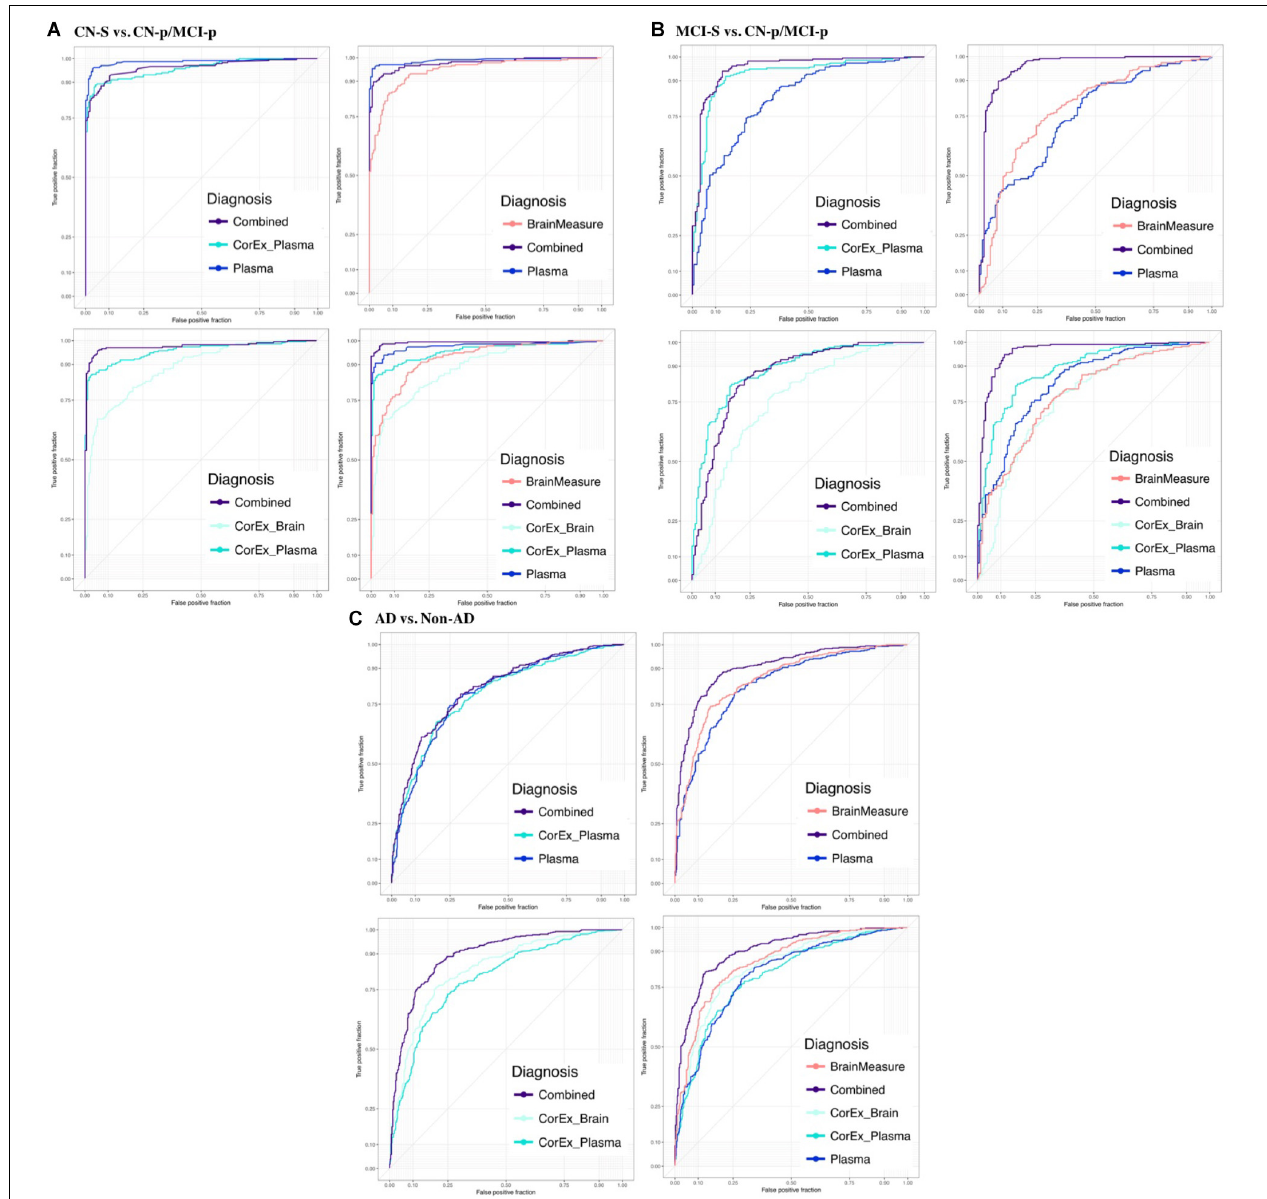
FIGURE 7 | Receiver operating characteristic plots for the average testing sets across diagnostic groups and feature types. We show the area under the ROC curve (AUC) averaged across testing repeats for (A) CN-s vs. CN-p/MCI-p, (B) MCI-s vs. CN-p/MCI-p, (C) non-AD vs. AD. We denote the progressing groups by “CN-p” or “MCI-p”. We included individual groups of measures (plasma, hallmarks of AD, demographics, and gray matter measures) and CorEx features in the prediction and explored different combinations of these feature groups to understand the benefit of including CorEx factors. Across diagnostic groups we largely see improved AUC with inclusion of CorEx factors. CorEx factors are outlined in Figures 2 , 3